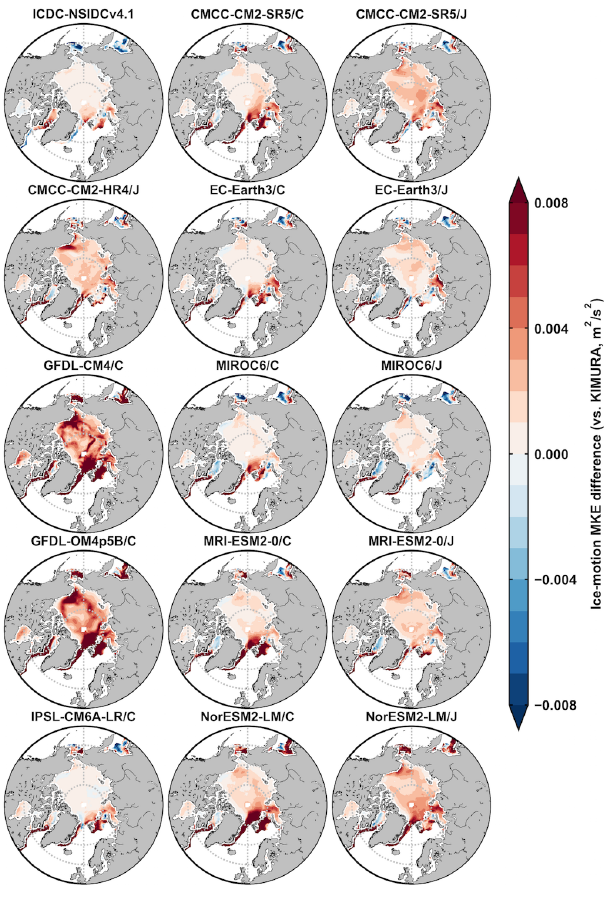
Figure A9. The 2003–2007 September mean Arctic ice-motion MKE differences between ICDC-NSIDCv4.1/model outputs and the KIMURA data (m 2 s − 2 ). The second and third columns are from the five OMIP1 and OMIP2 model outputs of CMCC-CM2- SR5, EC-Earth3, MIROC6, MRI-ESM2-0, and NorESM2-LM, re- spectively.